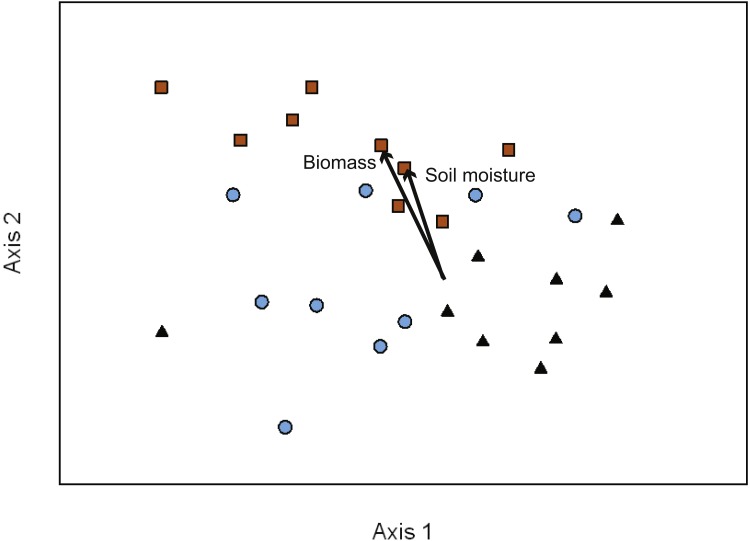
NMDS ordination of EMF communities associated with each transect (10 seedlings per transect).Symbols represent the two treatments in the variable retention timber management system and primary forests stands. Primary forest, black triangles; aggregate retention, blue circles; dispersed retention, orange squares. Proportion of variance explained by each axis: Axis 1 = 21.3%, Axis 2 = 18.7%, and Axis 3 = 35.2%. The vectors indicate the magnitude and direction of the relationship. The ordination indicates that differences in composition were greatest between dispersed retention and aggregate retention or primary forest stands.